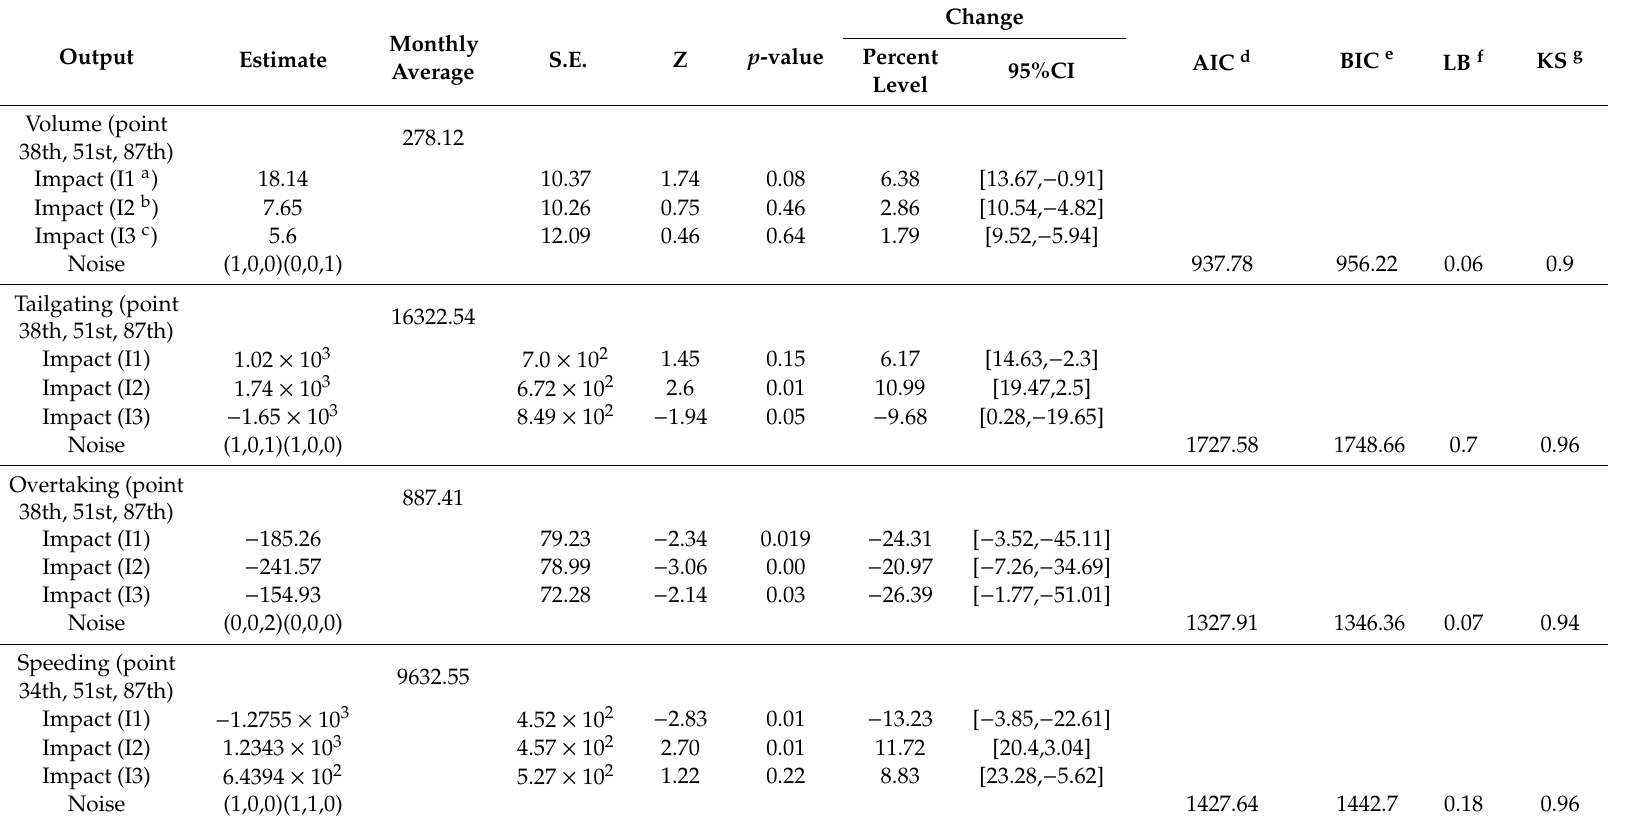
Table 1. The e ff ects of tra ffi c interventions on road tra ffi c o ff enses and volume in Iranian rural areas, SARIMA